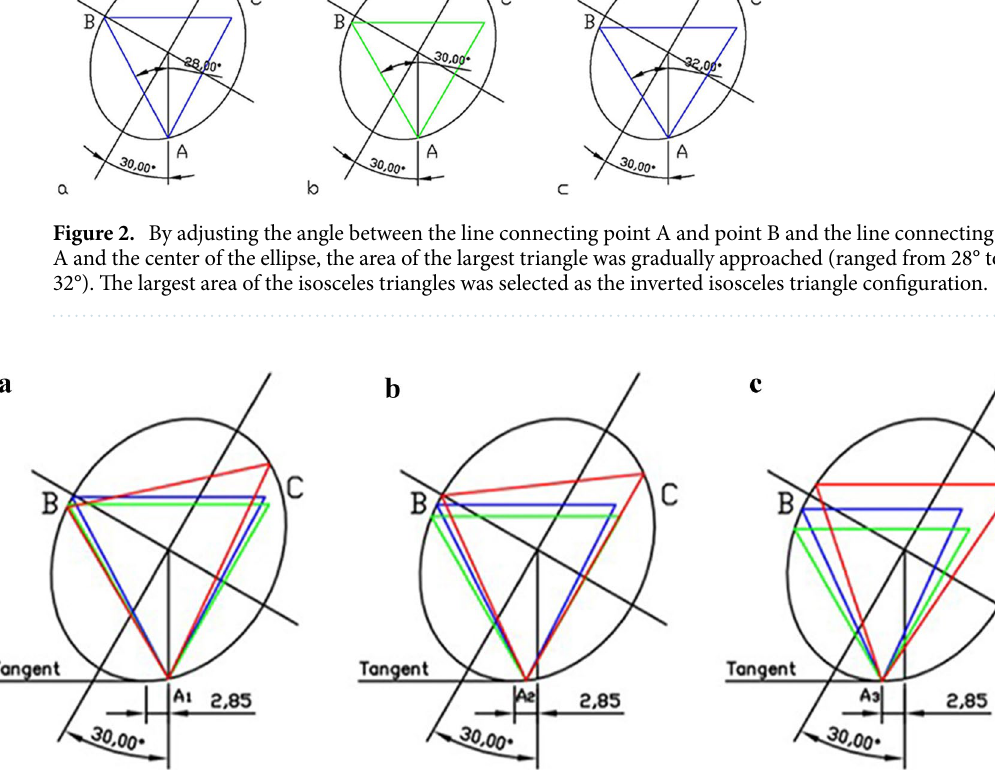
Figure 3. In the ellipse model, when the femoral calcar screws were positioned at different points (A1, A2, A3), there were three triangle configurations. The red triangle is OT; the blue is MA-IIT; the green is IET. ( a ) The femoral calcar screw is located at point A1 below the femoral neck; ( b ) the femoral calcar screw was located at point A2, and the midpoint of point A1 and A3; ( c ) the femoral calcar screw was located at point A3: The lowest point of the femoral neck in the anterior and posterior position. At this time, the screw was not located at the midline of the femoral neck cross-section while was located backward relative to the vertical angle of the ellipse in the first model was set at 10°, 20°, 30°, 40°, and the area and eccentricity are fixed. The second model was to adjust the ellipse area (the semi-major axis was 12.5, 15, 17.5, and 20 mm), and the torsion angle and eccentricity remain the same. The third model was to adjust the ellipse eccentricity (0.4, 0.5, 0.6, 0.7). The largest inscribed triangle (OT), IET, and MA-IIT of the known fixed vertices in the ellipse, and the area and